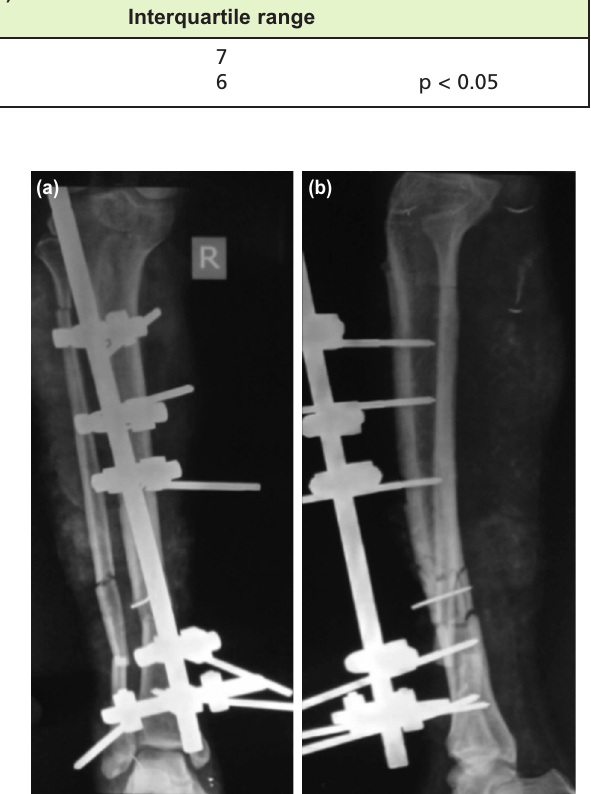
(a) Anterior posterior and (b) lateral plain radiograph Fig. 2: showing tibia fracture treated with debridement and external fixation.